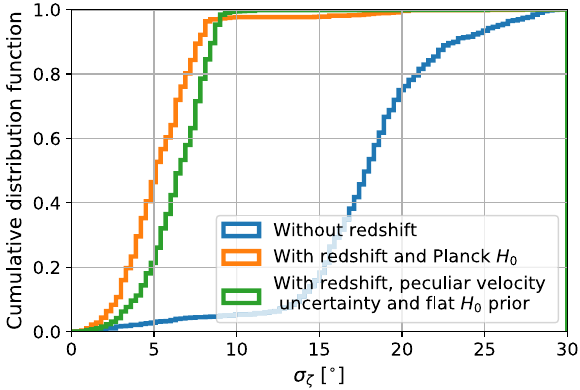
FIG. 5. Cumulative distribution function of 1 σ viewing angle uncertainty for BNS detected by Advanced LIGO-Virgo at design sensitivity. The sky positions for all events in the distributions are assumed to be precisely